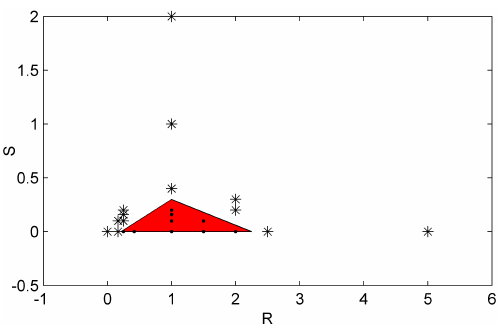
Figure 16. The range of R and S parameters studied and the de- pendence of qualitative features of the collision between eddies and obstacles. The star symbols represent no eddy splitting in the colli- sion, and the solid dots represent eddy splitting. The red area is the range of eddy